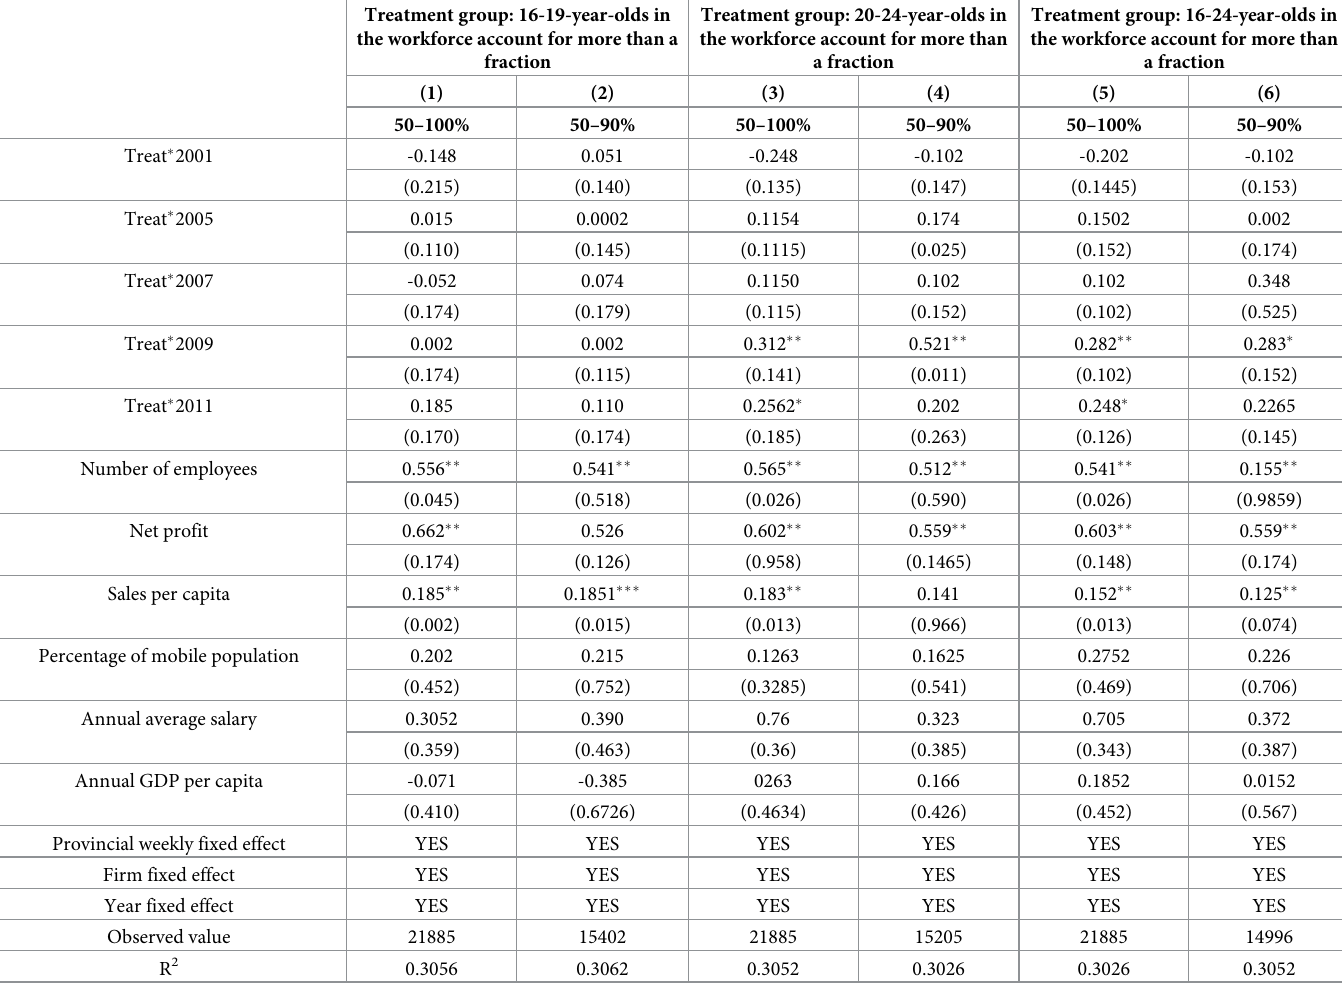
Table 4. Dynamic impact